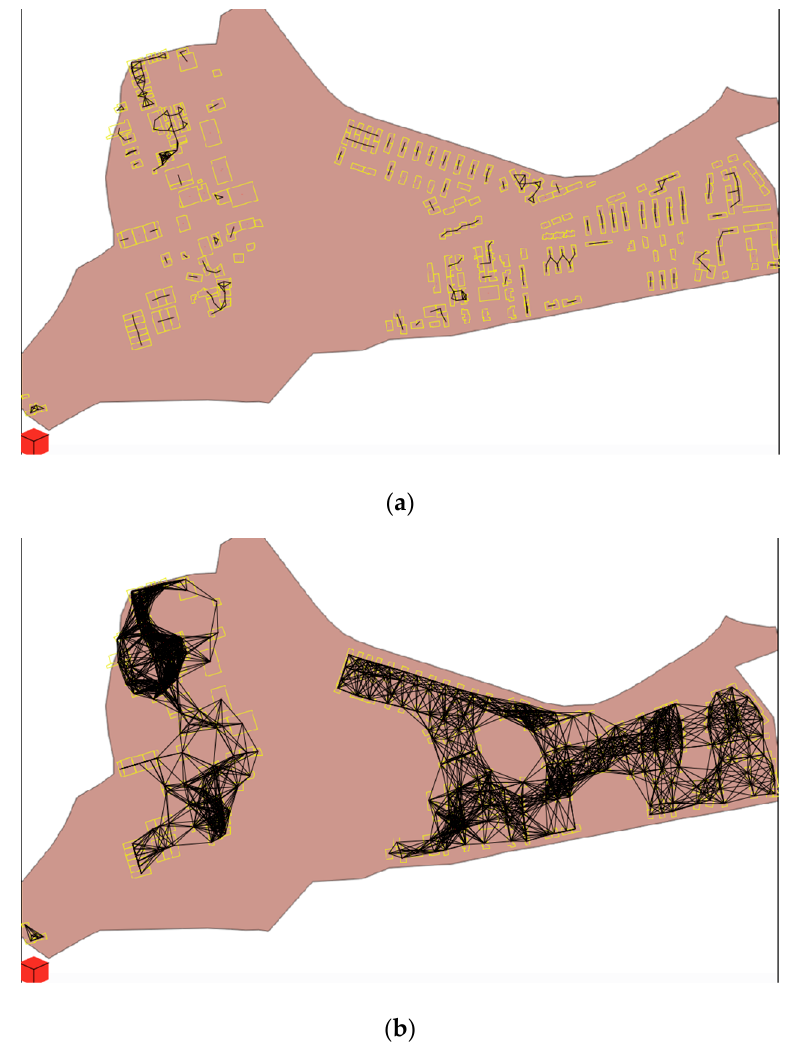
Figure 5. Case study area for ( a ) nodes connected with radius = 50 m, ( b ) nodes connected with radius = 200 m